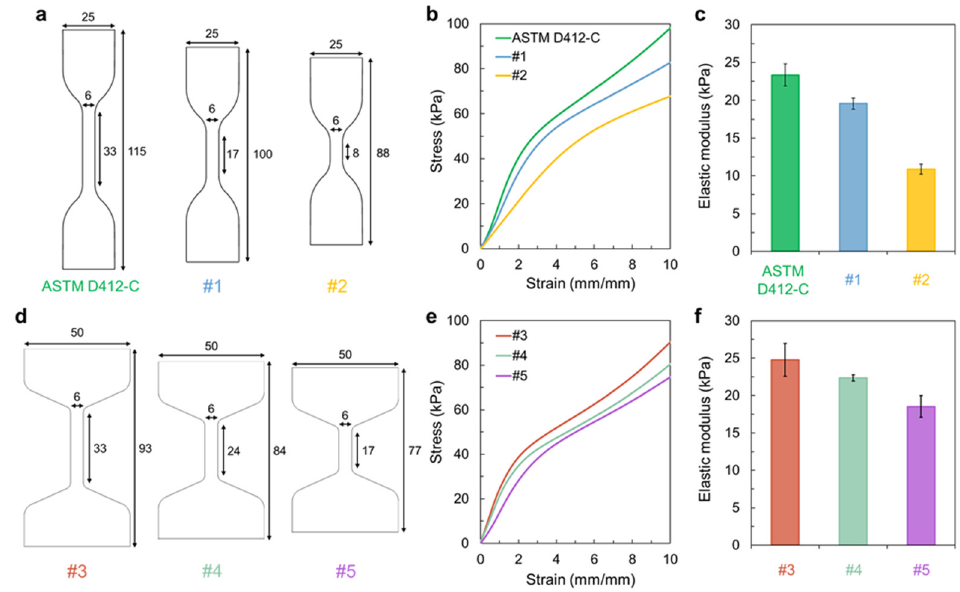
Figure 2. ( a , d ) Specimen dimensions of dumbbell shape with a different gauge length. ( b , e ) Stress- strain curve and ( c , f ) elastic modulus of hydrogels with different dimensions.